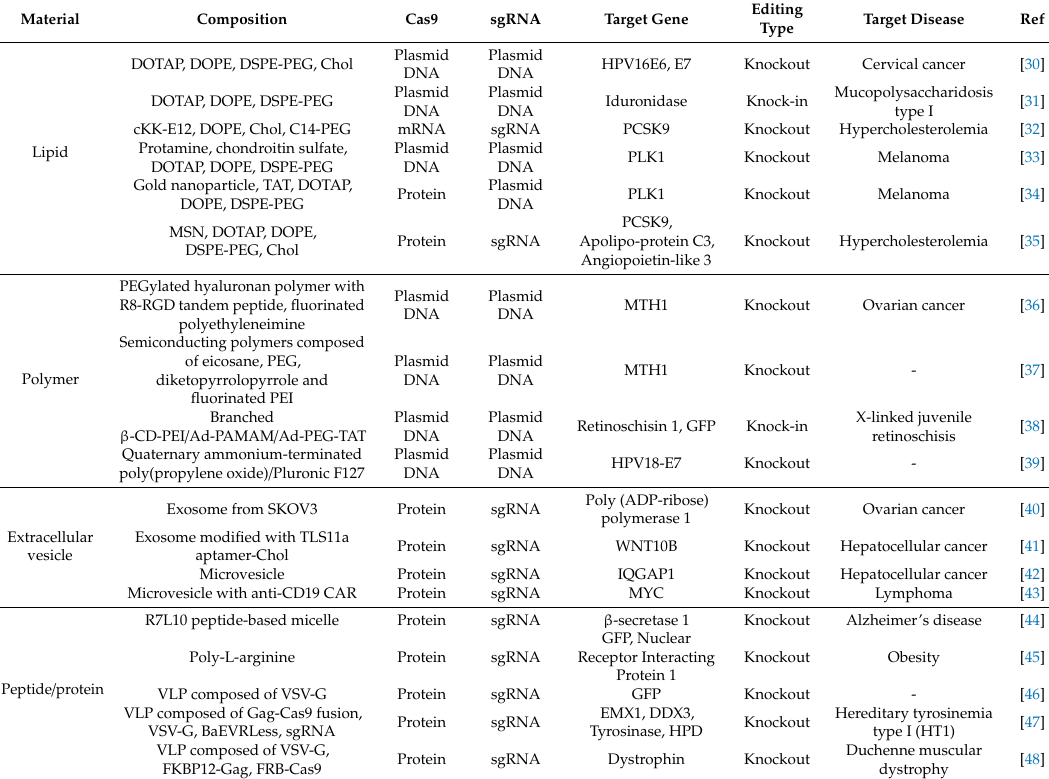
Table 1. Nanovesicle materials for CRISPR / Cas9 and sgRNA